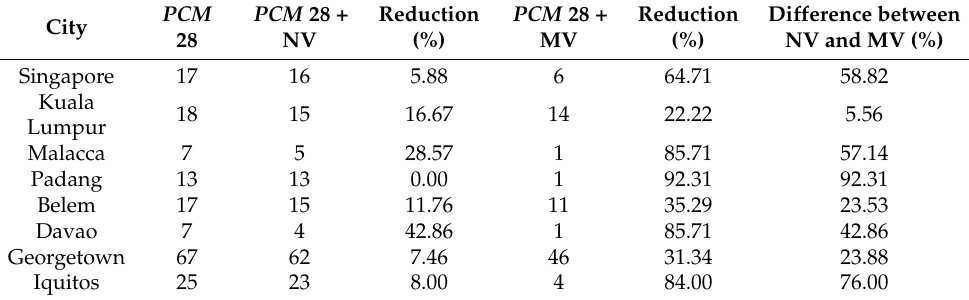
Table 7. The number of “negative